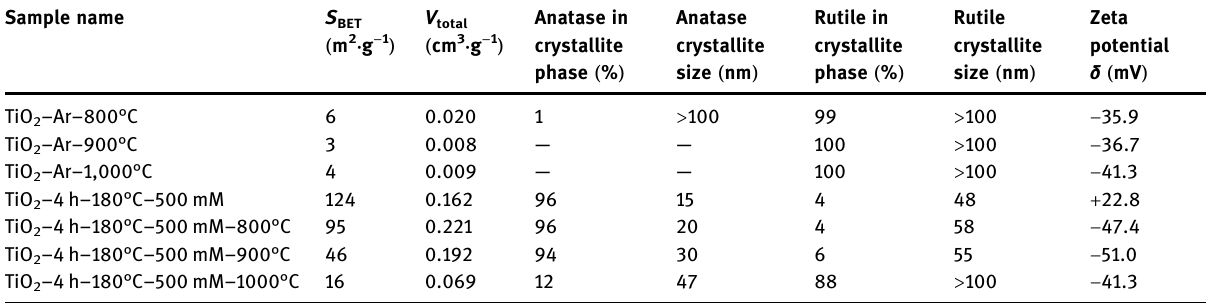
Table 1: Physicochemical properties of starting - TiO 2 , reference samples, and APTES - modi fi ed TiO 2 nanomaterials [ 20 ]